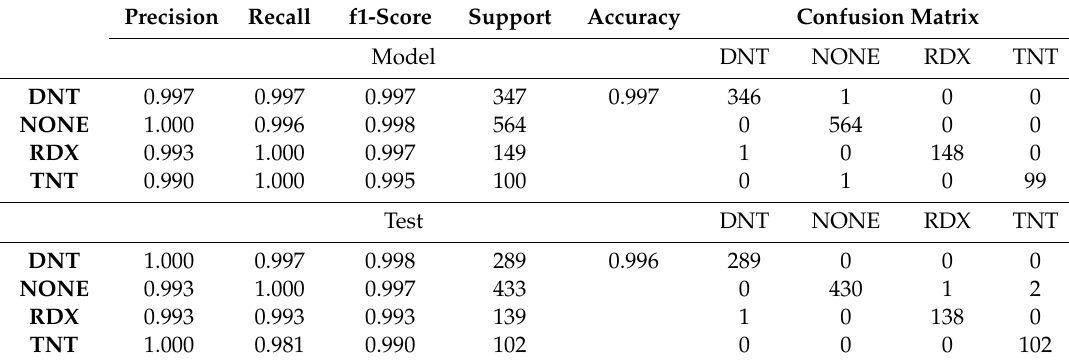
Table 7. Confusion matrix and evaluation criteria for the random forest classification model.